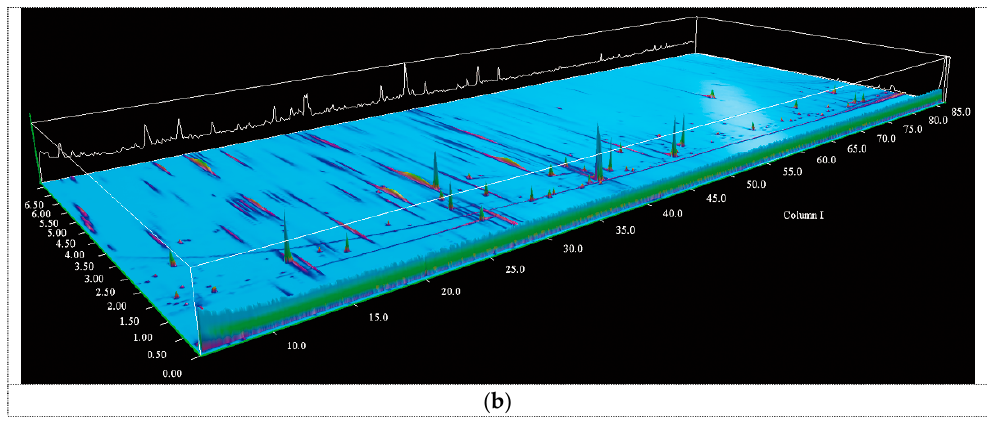
Figure 1. The 3D chromatogram image of volatiles detected by comprehensive two-dimensional gas chromatography (GC × GC) high resolution time-of-flight mass spectrometry (HR-TOF/MS): ( a ) black truffle (BT); ( b ) white truffle (WT).